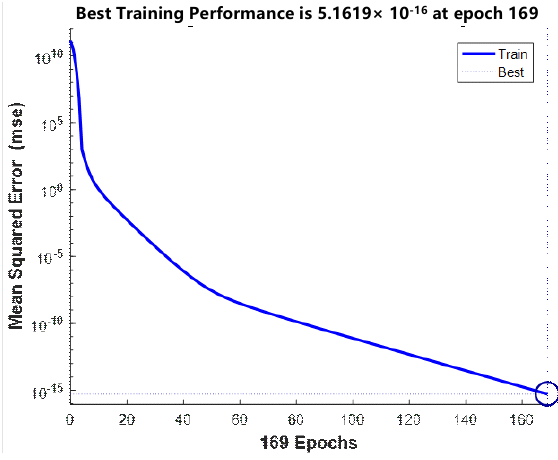
Figure A2. Performance of BP neural network training.